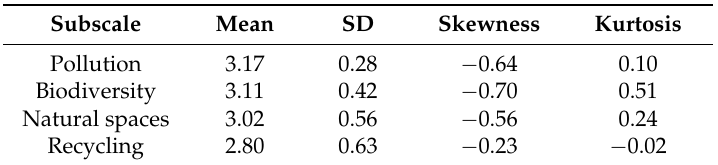
Table 2. Descriptive statistics.